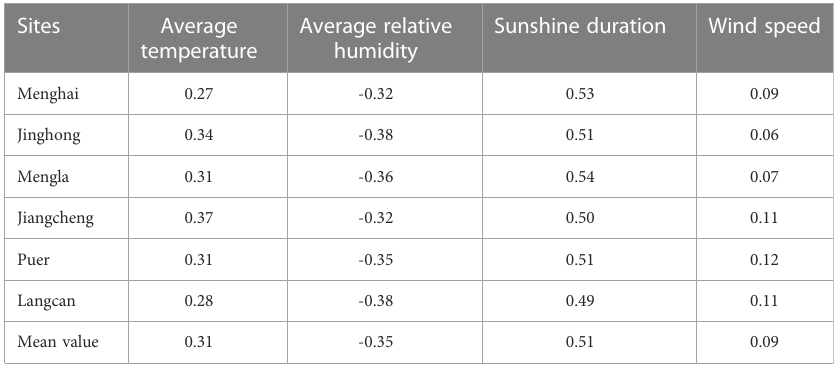
TABLE 3 Correlation coef fi cients of ET 0 and meteorological